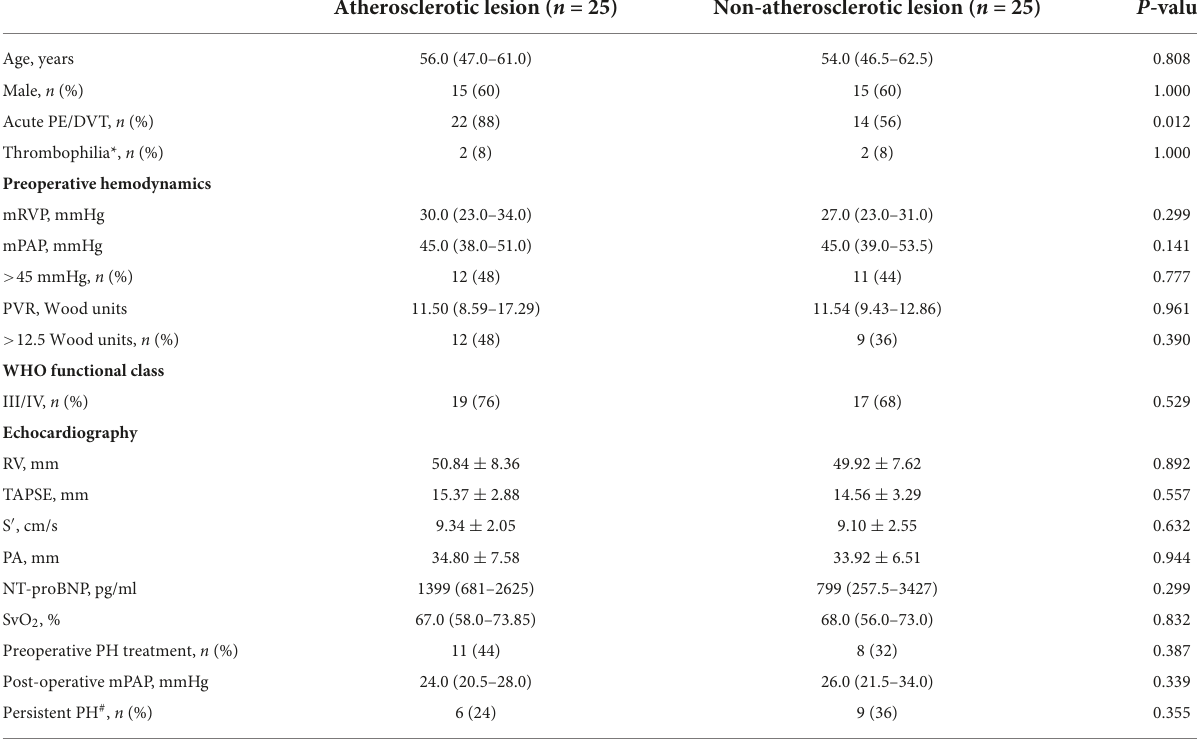
TABLE 1 Demographic and hemodynamic characteristics of the study population. Atherosclerotic lesion ( n = 25) Non-atherosclerotic lesion ( n =